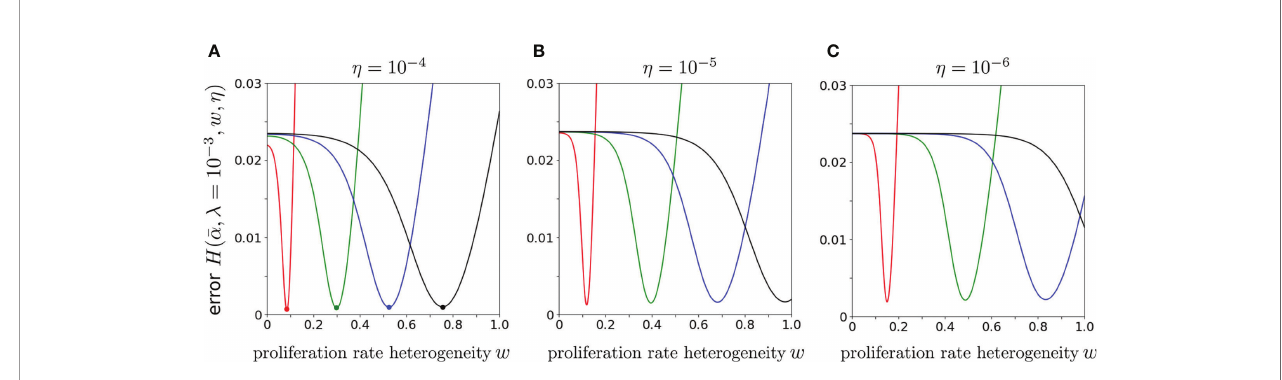
FIGURE 8 | The error H ( (cid:2) a , l , w , h ) using CD4 alpha data from Oakes et al. (12) plotted as a function of w for various l = (cid:2) a . We fi xed l = 10 -3 and varied, from left to right, (cid:2) a = 2 (cid:4) 10 − 5 (red), 6 × 10 -5 (green), 10 -4 (blue) and 1.4 × 10 -4 (black). From (A – C) , h = 10 -4 , 10 -5 , and 10 -6 . Smaller values of l = (cid:2) a result in larger best- fi t values of